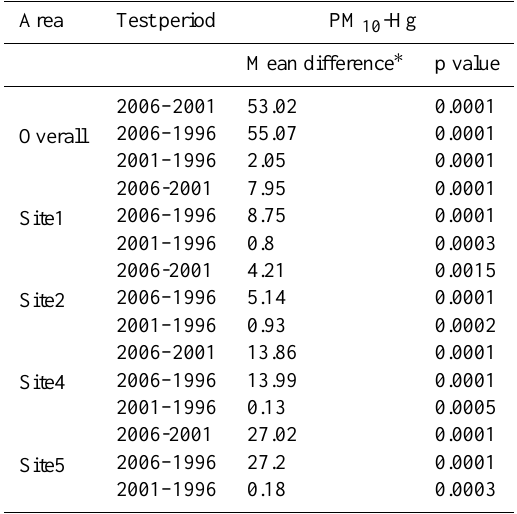
Table 3. Results of Kruskal wallis multiple comparison test of yearly difference ambient mercury around integrated steel